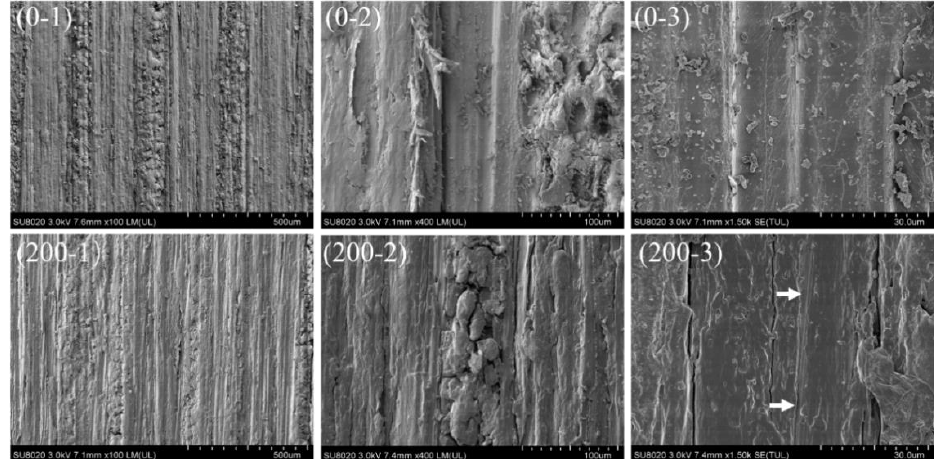
Figure 4. SEM image of a tangential section of OBFRC (0-N) before and (200-N) after UV irradiation for 200 h. Note: N (1 – 3) denotes different regions of the tangential section.